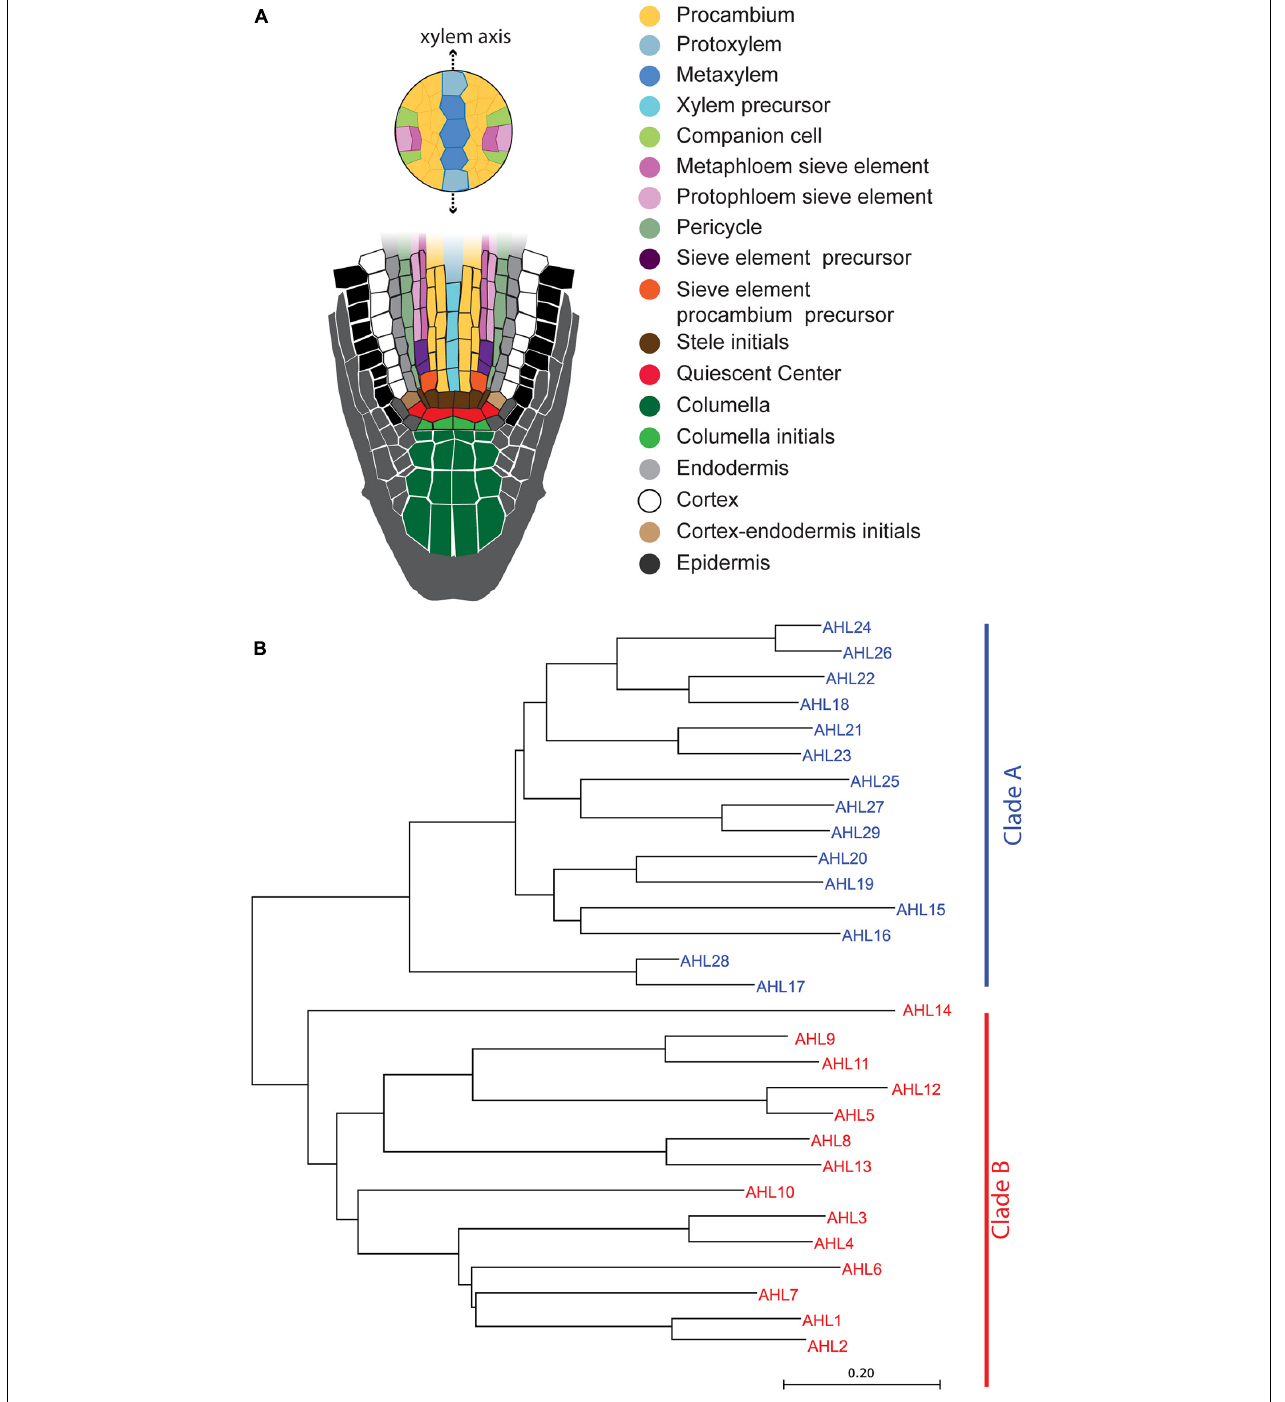
FIGURE 1 | Schematic illustration of the Arabidopsis root apical meristem and phylogenetic tree of AT-HOOK MOTIF NUCLEAR LOCALIZED PROTEINS (AHLs): (A) schematic illustration of the Arabidopsis root apical meristem. (B) Phylogenetic tree of AHL proteins in Arabidopsis . The evolutionary history was inferred using the neighbor-joining method (Saitou and Nei, 1987). The optimal tree with the sum of the branch length being 10.17264217 is shown. The tree is drawn to scale, with branch lengths in the units identical to those of the evolutionary distances used to infer the phylogenetic tree.